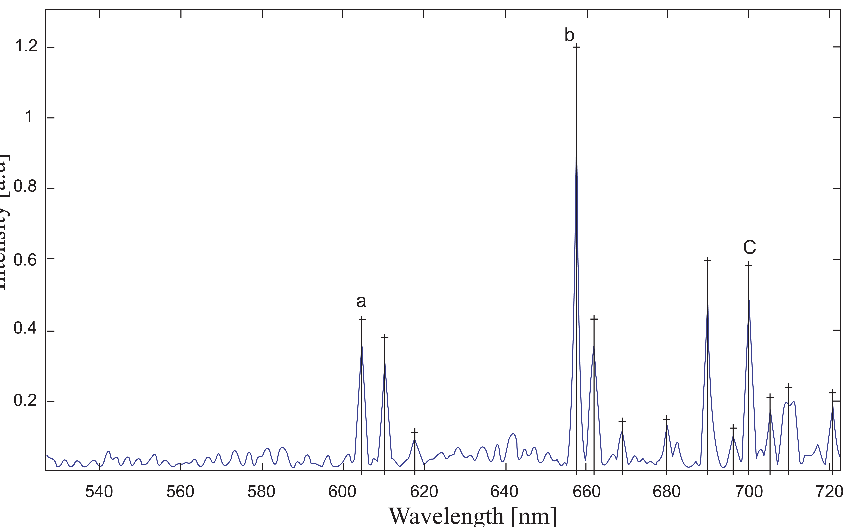
Figure 9. Photoluminescence spectrum of ZnSe co-doped with Eu 3+ /Yb 3+ at 200 K after eliminating the ZnSe bands. a is the emission line of pure ZnSe and b, C are the new emission lines due to dopants.